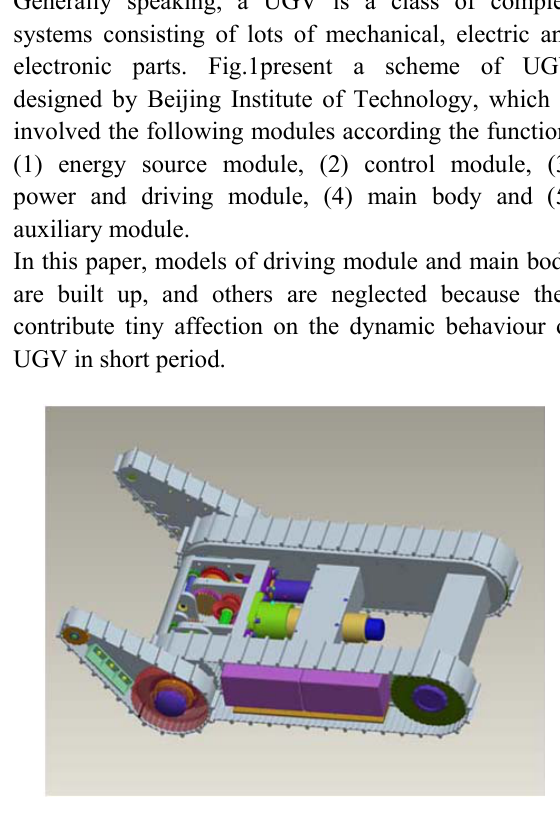
Fig.1. Prototype of Miniature